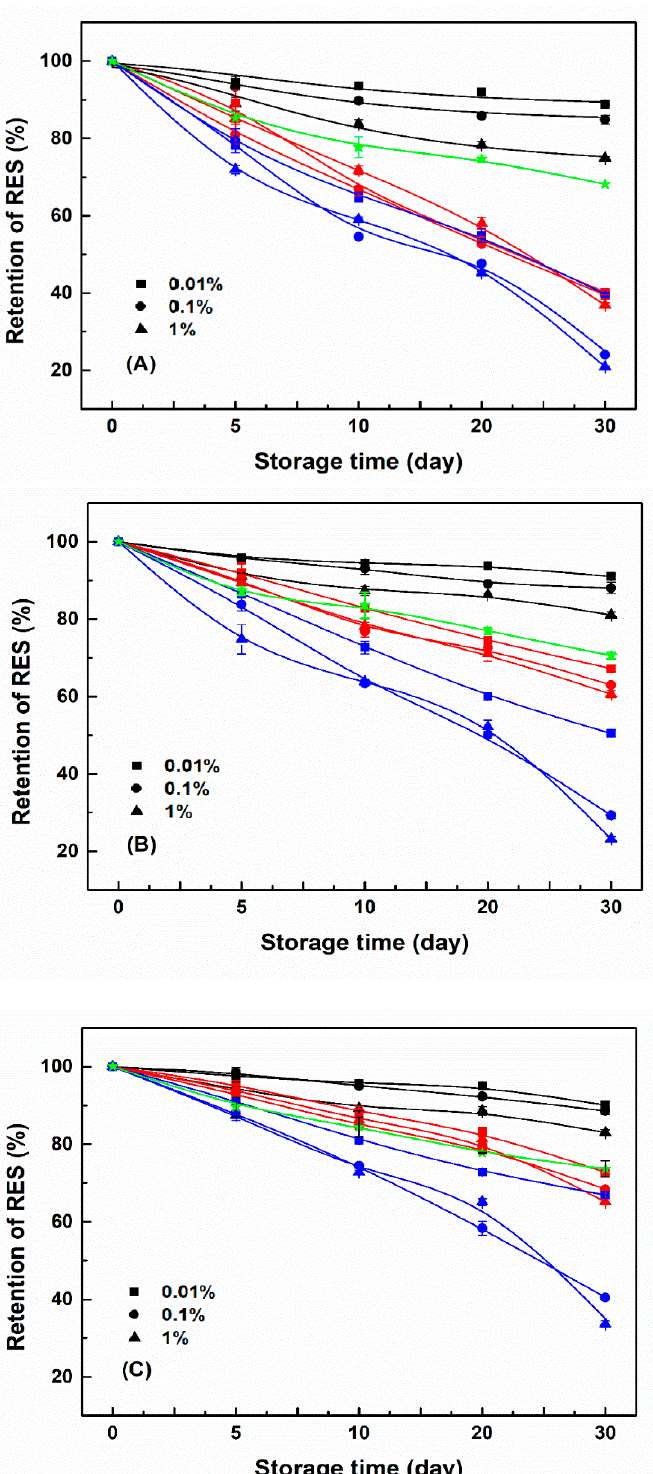
Figure 9. Retention of resveratrol alone (green) and in its WPI (black), SC (red) and SPI (blue) complex particles at various protein concentrations during storage at 45 °C. The concentrations of resveratrol were 25 ( A ), 50 ( B ) and 100 ( C ) μ M.